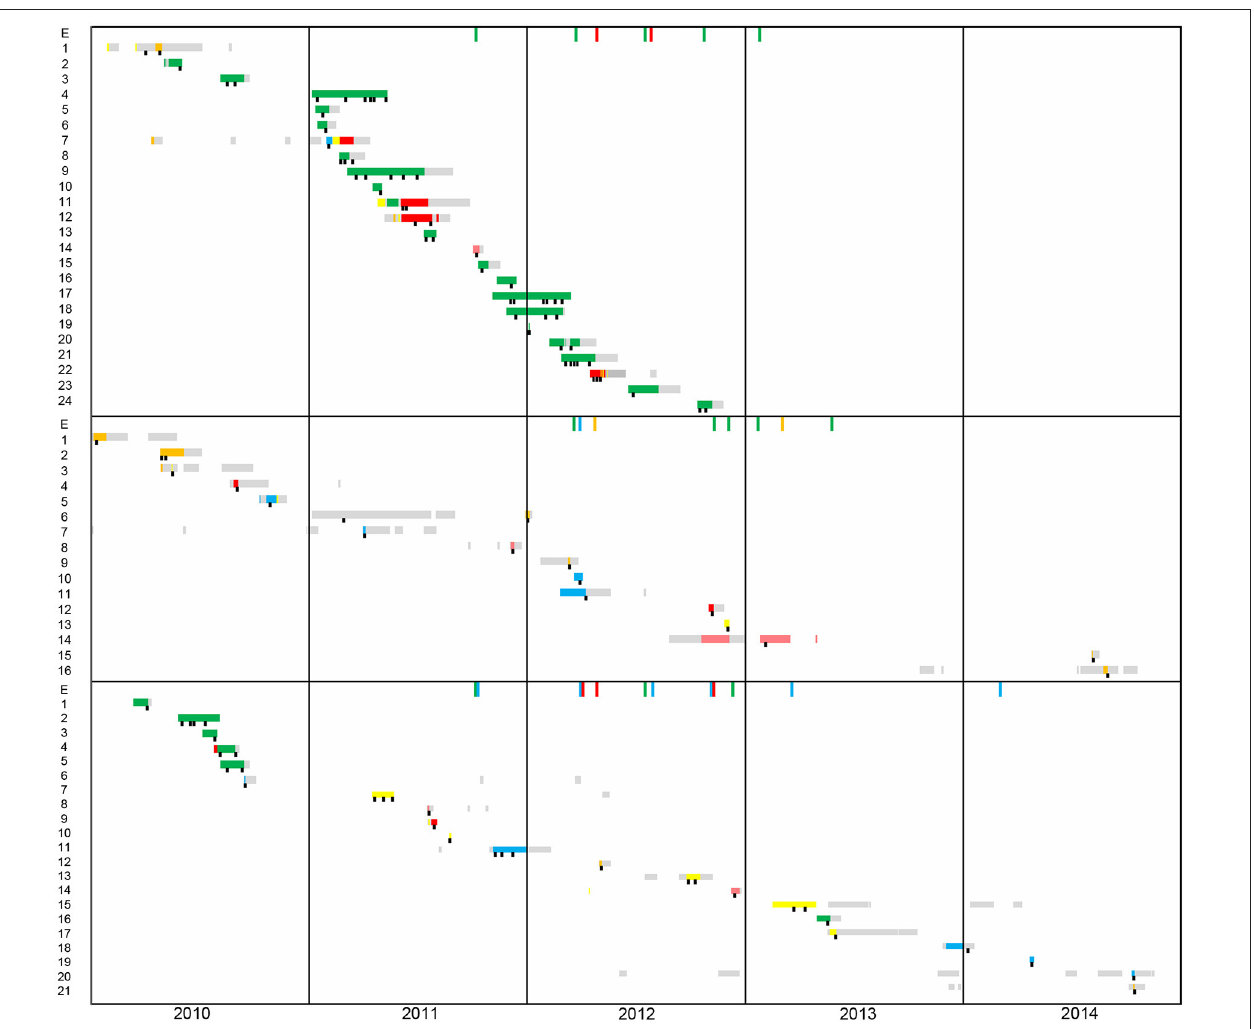
FIGURE 1 | Timeline of patient’s hospital stay from 2010 to 2014. The first panel corresponds to patients harboring DLST 1–18 ( N = 24), the second to DLST 1–21 ( N = 16), and the third to DLST 6–7 ( N = 21). Each line represents the patient hospitalization period (yellow, ICU1; blue, ICU2; green, ICU3; orange, ICU4; pink Pediatric-ICU; gray, other wards). A black square represents the time points at which P. aeruginosa was isolated.